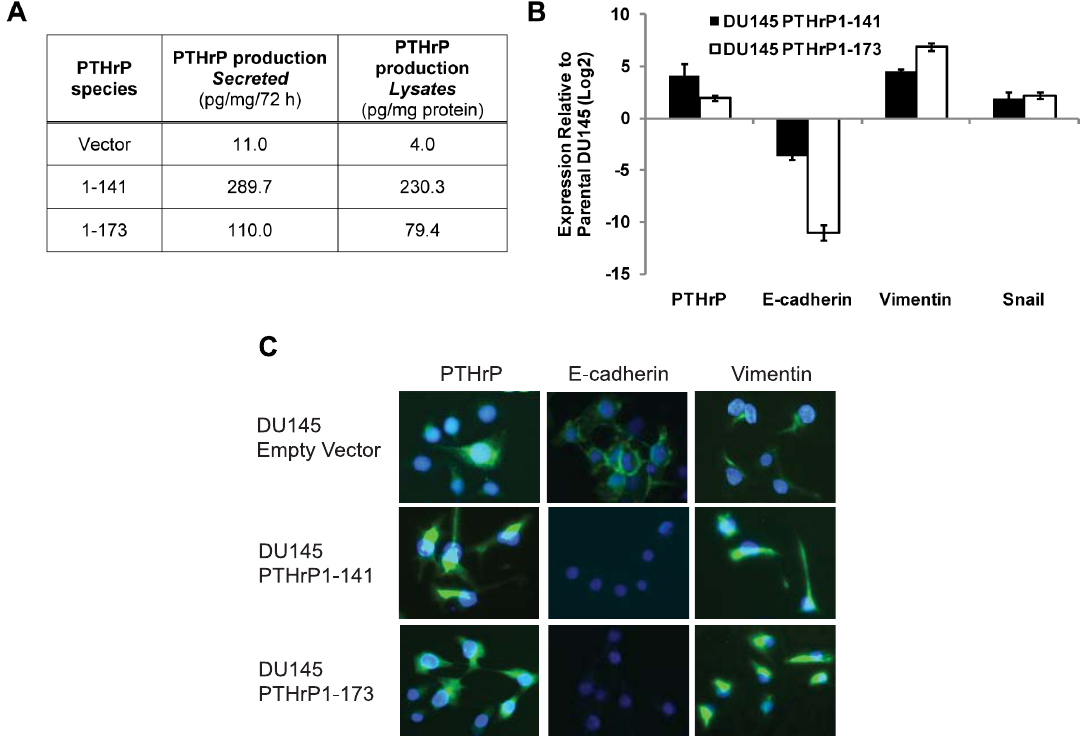
Figure 1. PTHrP overexpression induces EMT. A) Quantification of PTHrP protein levels in control and PTHrP-overexpressing DU 145 cells by immunoassay. B) mRNA expression of PTHrP and EMT markers in control and PTHrP-overexpressing DU 145 cells. C) Immunofluorescence images confirming the overexpression of PTHrP, the upregulation of vimentin, and downregulation of E-cadherin in PTHrP-overexpressing DU 145 cells.